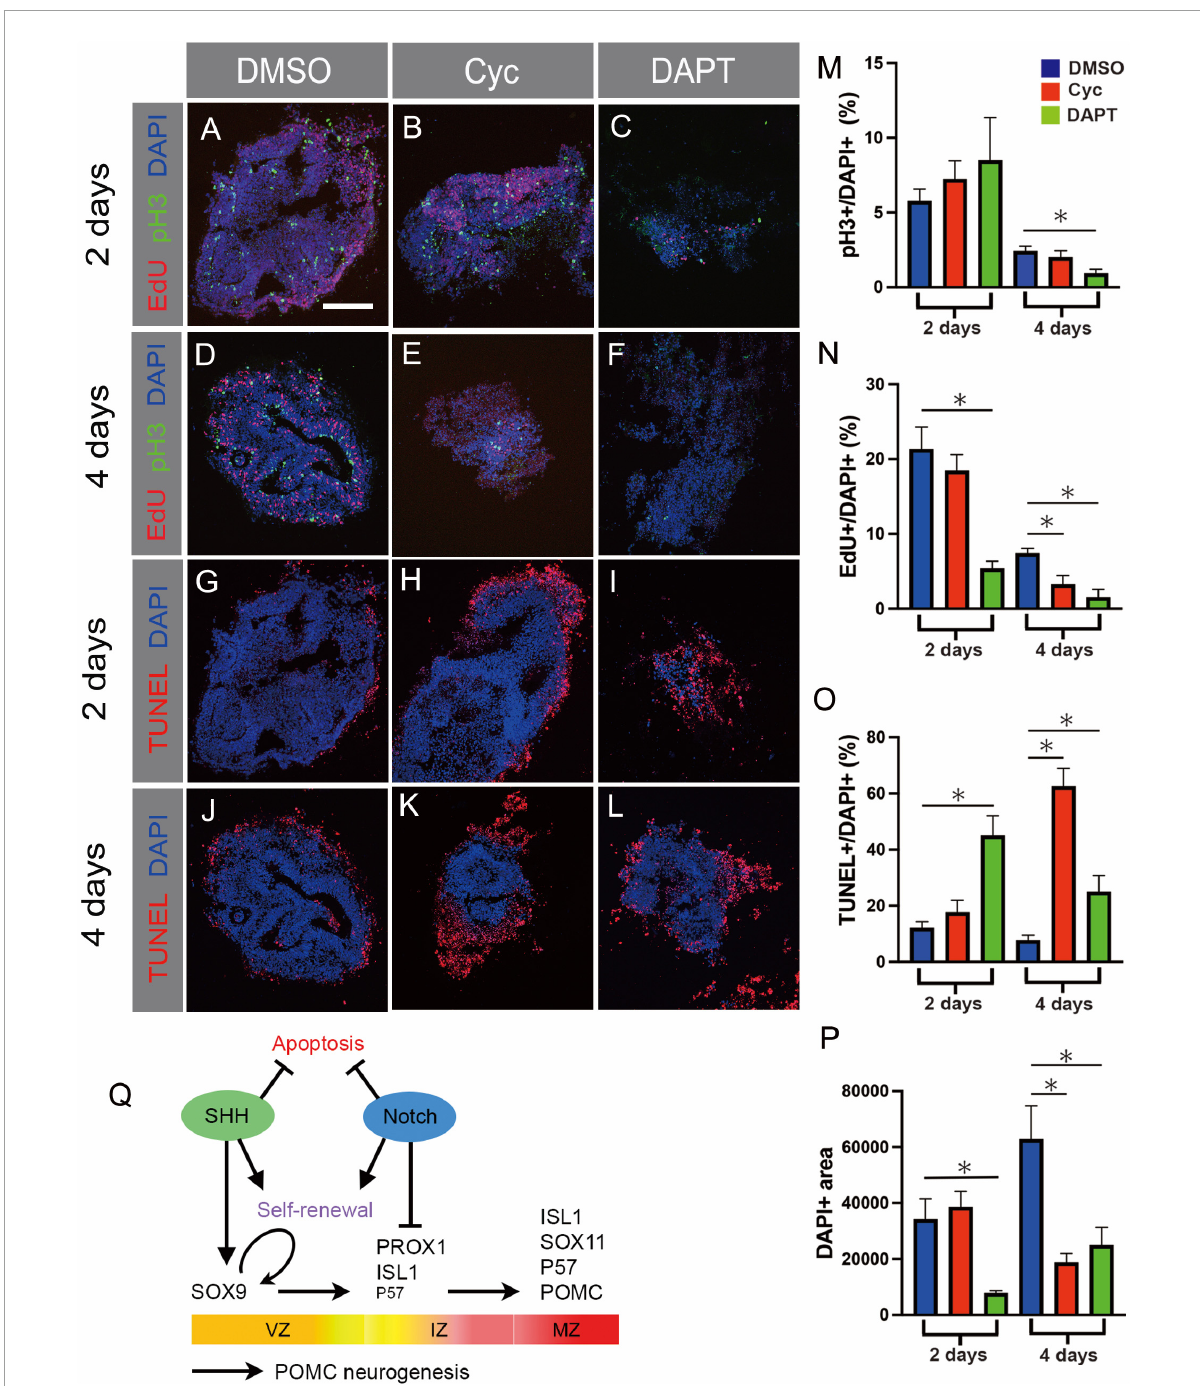
FIGURE6 (A–L) Prospective hypothalamic (pHyp) explants cultured in the presence of DMSO (A,D,G,J) , the SHH inhibitor cyclopamine (B,E,H,K) , or the Notch inhibitor DAPT (C,F,I,L) for 2 (A–C,G–I) or 4 (D–F,J–L) days. pH3 immunolabelling (M) , EdU detection (N) , and the TUNEL assay (L) were performed. (M–P) Quantification of results of ex vivo culture experiments on pHyp explants cultured for 2 or 4 days in the presence of DMSO or cyclopamine or DAPT. Image area staining positively for pH3 (M) , EdU (N) , or TUNEL signal (L) , normalised to total DAPI+ area. Relative DAPI+ area (P) . Mean ± SEM, n = 12–23 (2 days), n = 9–13 (4 days). Asterisks indicate statistical significance at p < 0.05. Scale bar: 160 µ m (A) . (Q) Schematic summarising transcription factor expression over the course of POMC neurogenesis. Curved arrow indicates self-renewal of SOX2+/SOX9+ VZ progenitor cells. Proposed roles of SHH signalling in inducing SOX9+ expression; of Notch signalling in inhibiting differentiation of IZ PROX1+ cells; and of both pathways in promoting self-renewal and inhibiting apoptosis, are indicated. Horizontal arrows indicate temporal progression of POMC neurogenesis. VZ, ventricular zone; IZ, intermediate zone; MZ, mantle